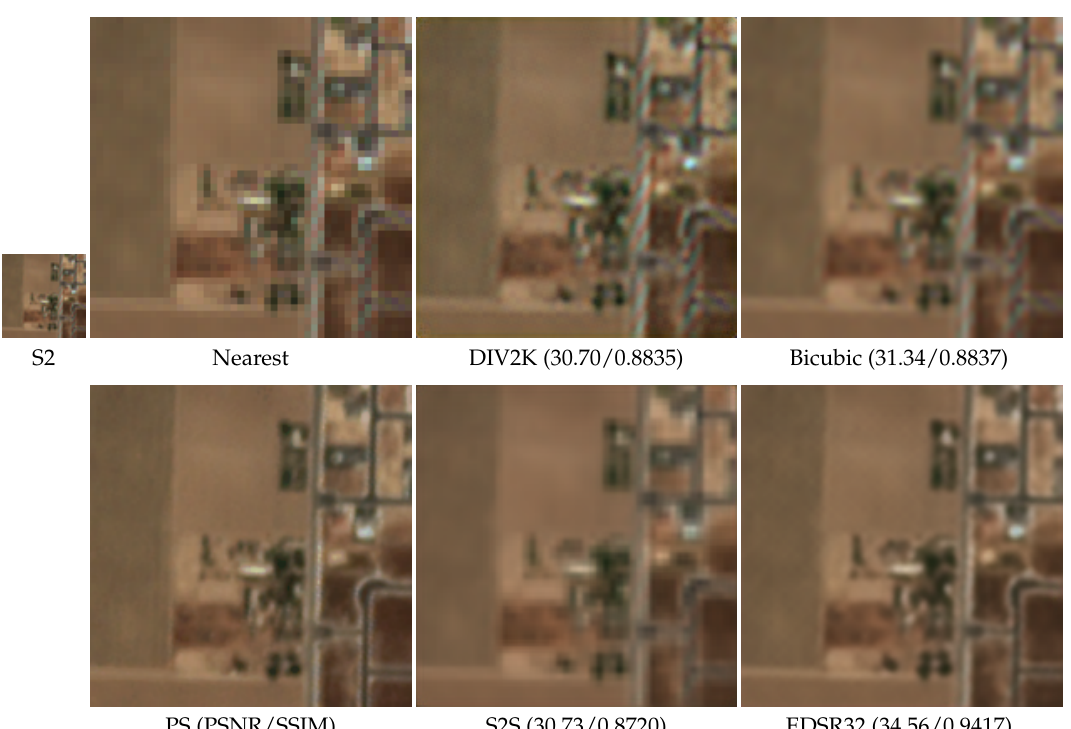
Figure A5. Visual comparison (RGB) of the baseline and EDSR32 models (tiles from test